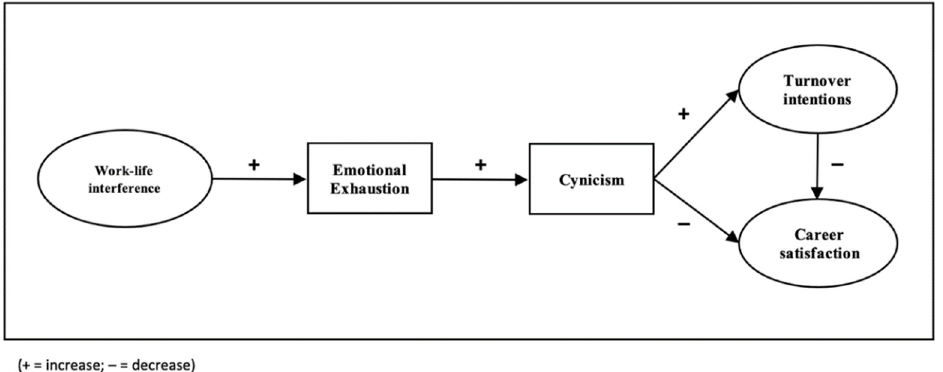
Figure 1. Hypothesized study model proposing the mediating effect of burnout (emotional exhaus- tion and cynicism) on the relationship between work-life interference, turnover intensions, and ca- reer satisfaction.